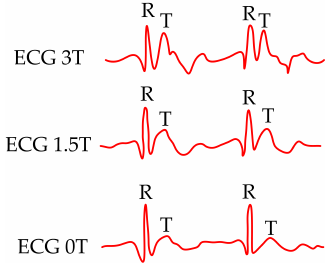
Figure 1. ECG signal in various types of magnetic fields (0 T, 1.5 T and 3